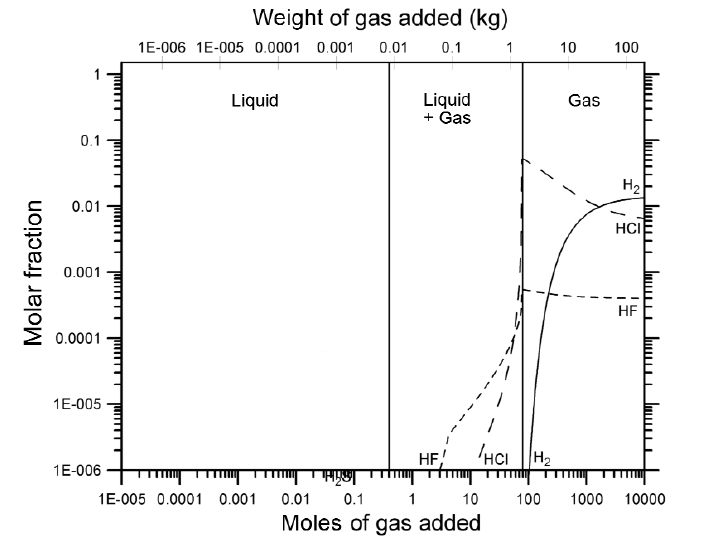
Fig. 12. Variations in the molar fractions of H 2( g ) , HCl ( g ) , and HF ( g ) during the progressive addition of hot (915°C) magmatic gas into 1000 g of pure water initially at 25°C. Pressure was kept at 0.1 MPa throughout the